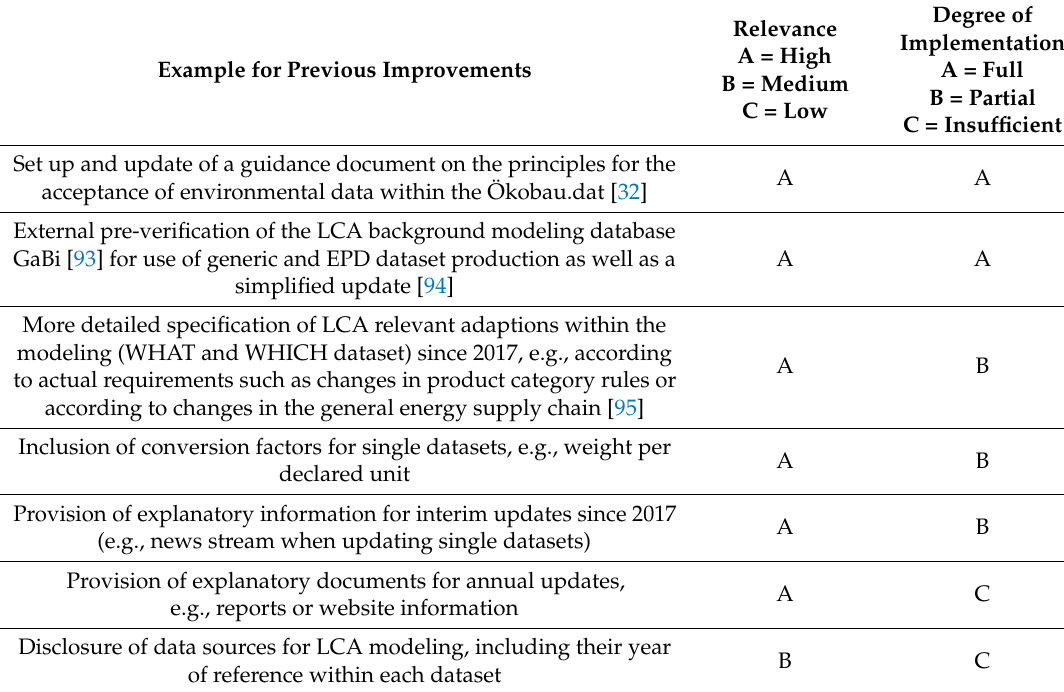
Table 1. Examples for previous improvements to enhance transparency and quality in